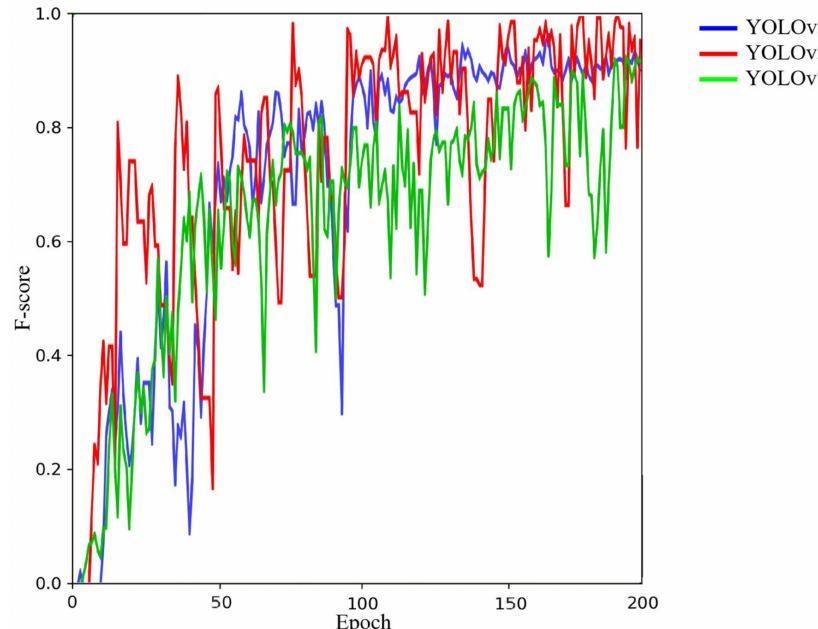
Figure 13. F1-score curve.